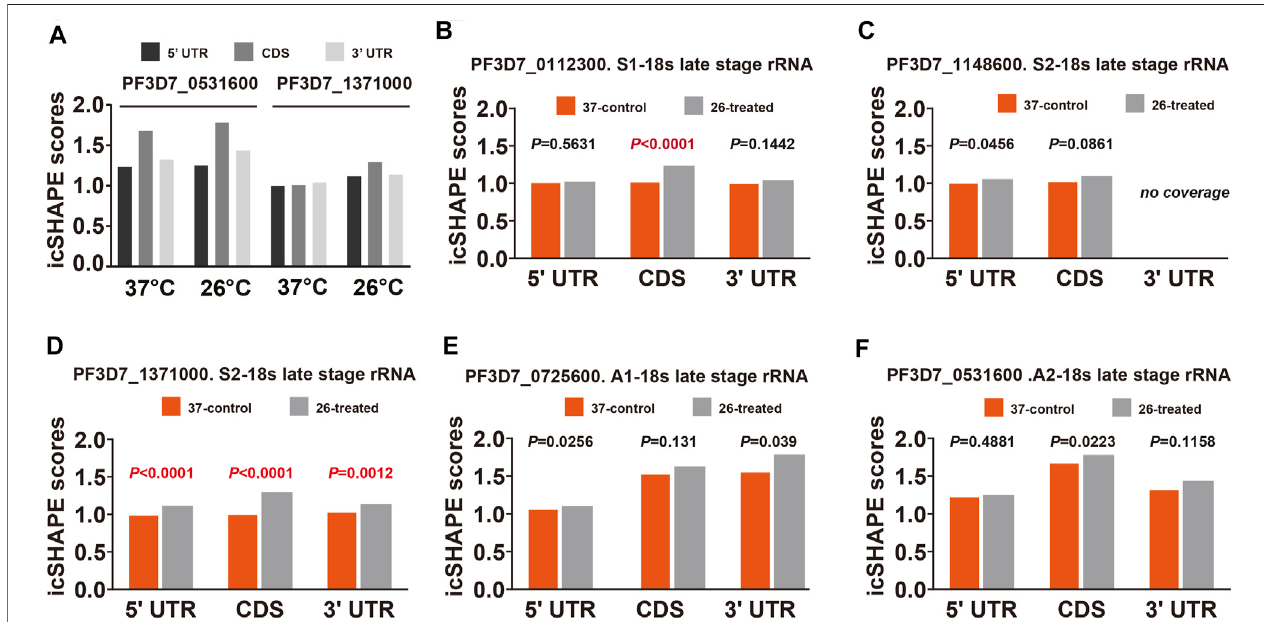
FIGURE5| AverageicSHAPEonall fi vesubtypesofrRNA ’ sthreeregionsattwotemperatures. (A) ComparisonofthemeanaverageicSHAPEscoresat37 ° Cand 26 ° Cin the 5 ′ -UTR, CDS, and 3 ′ -UTR regions of 18S A2-type rRNA (PF3D7_0531600) and S2-type RNA (PF3D7_1371000). The mean average icSHAPE scores in the 5 ′ -UTR region, CDS region, and 3 ′ -UTR regions in S1-type (B) , S2-type on chromosome 11 (C) , S2-type on chromosome 13 (D) , A1-type (E) , and A2-type (F) of 18S ribosomal RNA. The average icSHAPE scores are signi fi cantly greater after 26 ° C treatment for all S2-type 18s rRNA subregions (D) , while the average icSHAPE scoresfromthreesubregionsofA1-type (E) andA2-type (F) 18srRNAarenotsigni fi cantbetween37 ° Cand26 ° C.TheaverageicSHAPEscoresfromthreesubregionsof S1-type18srRNAonchromosome1 (B) andS2-type18srRNAonchromosome11 (C) arenotsigni fi cantbetween37 ° Cand26 ° Cduetothelowernucleotidecoverage ( Supplementary Table S5 ). icSHAPE scores on whole transcripts were cross-normalized between different temperatures ( Materials and Methods ). Speci fi c p values for each comparison and coverage of each transcript are provided in Supplementary Table S4 .